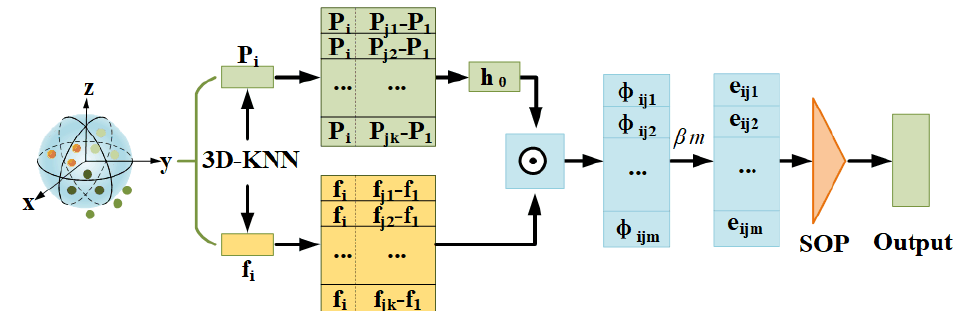
Figure 1. Processing flow of AWConvMLP. Firstly, the local aggregation network extracts the features of target point P, convolutes its relative position, then calculates the aggregation weight of all dimensional convolution kernels and finally extracts the feature by channel symmetric aggregation function (Max, average or sum. Here, max pooling is used